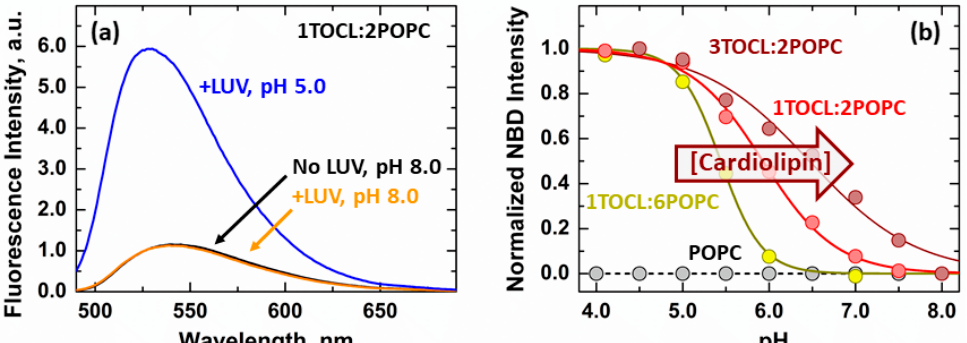
Figure 3 . Fluorescence measurements of membrane interaction of the α 1-2 loop. ( a ) Acidification of Bcl-xL G70C-NBD in the presence of anionic large unilamellar vesicles (LUV) containing 1TOCL (cardiolipin):2POPC led to a 6-fold increase in fluorescence intensity (blue) compared to measurements at pH 8 (orange), accompanied by a 14 nm blue shift of the NBD emission spectrum from 542 to 528 nm. Both effects are characteristic of the transition of NBD to hydrophobic environments and indicate the protonation-induced membrane association of the α 1-2 loop. ( b ) The bilayer interaction of the α 1-2 loop was measured as a function of pH in membranes with increasing cardiolipin content. The presence of higher molar ratios of cardiolipin led to more neutral pK a values, indicative of more favorable membrane interactions. The data is presented as the increase in fluorescence intensity associated with the membrane partitioning of G70-NBD measured at 510 nm.